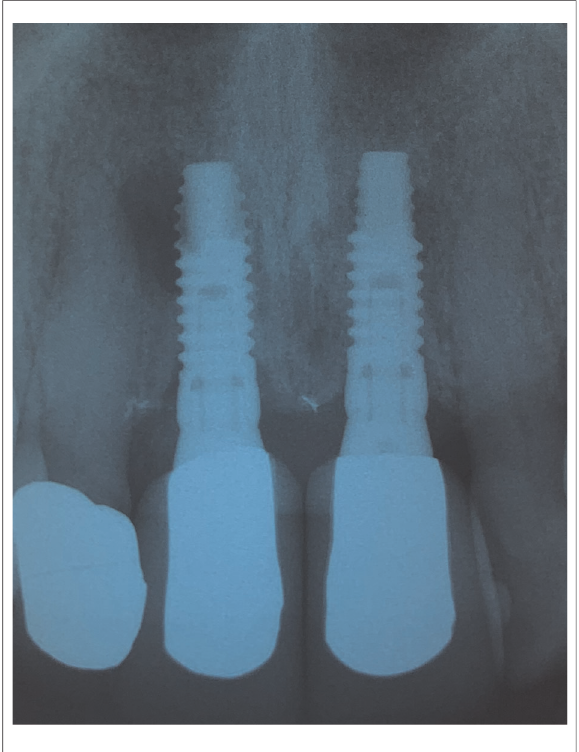
FIGURE 1 Periapical post-operative radiograph.